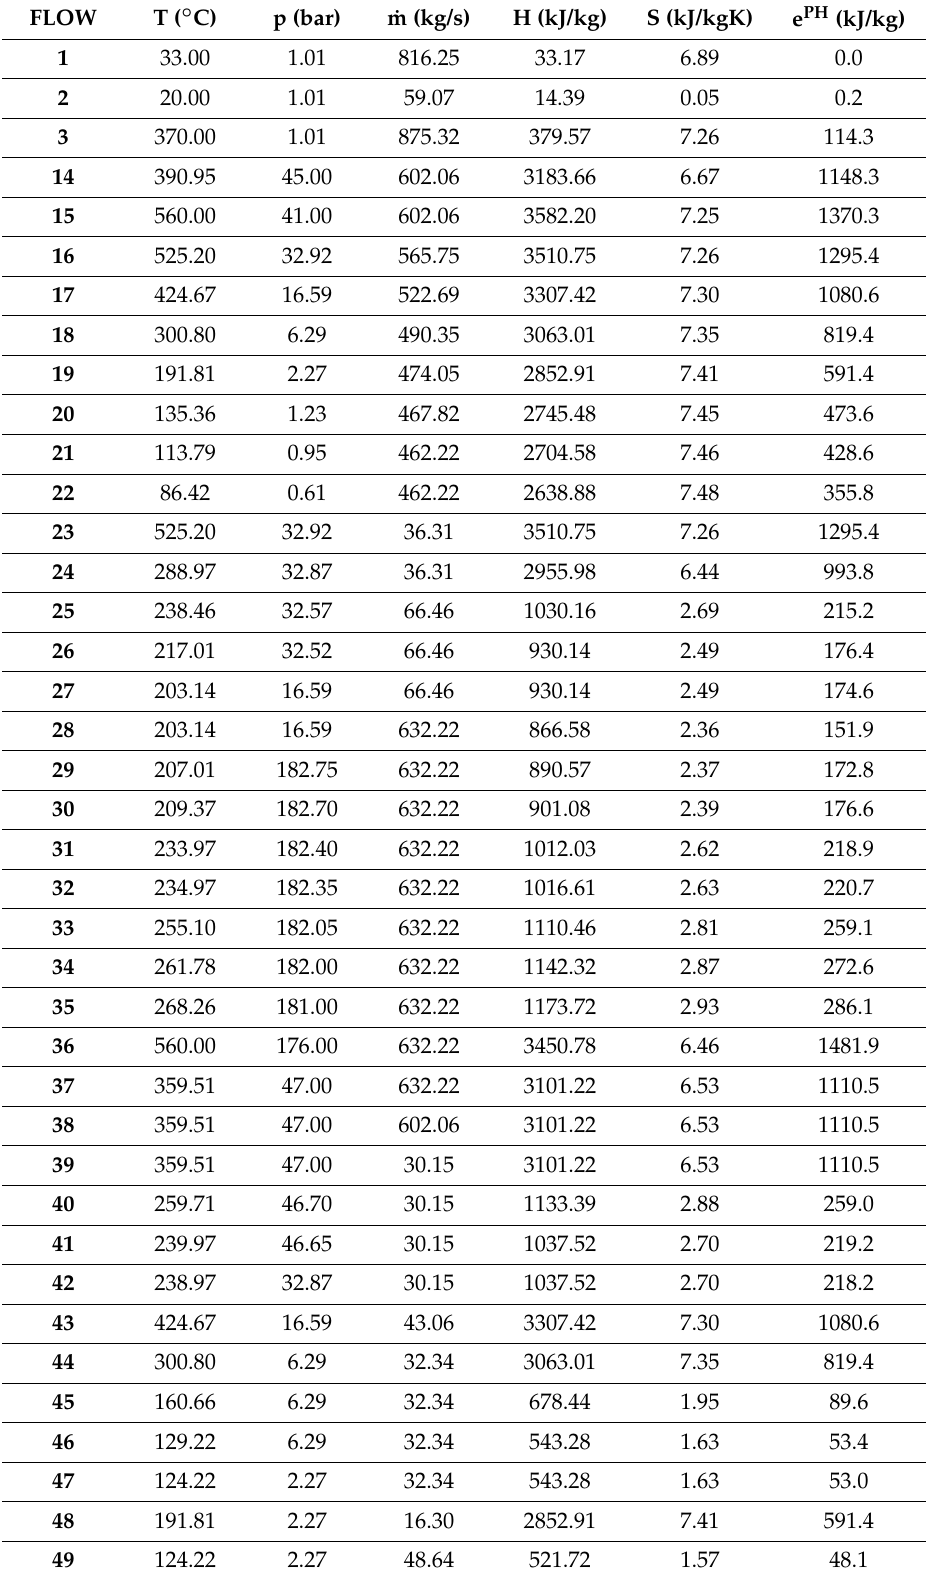
Table A1. Stream-level thermodynamic results of the